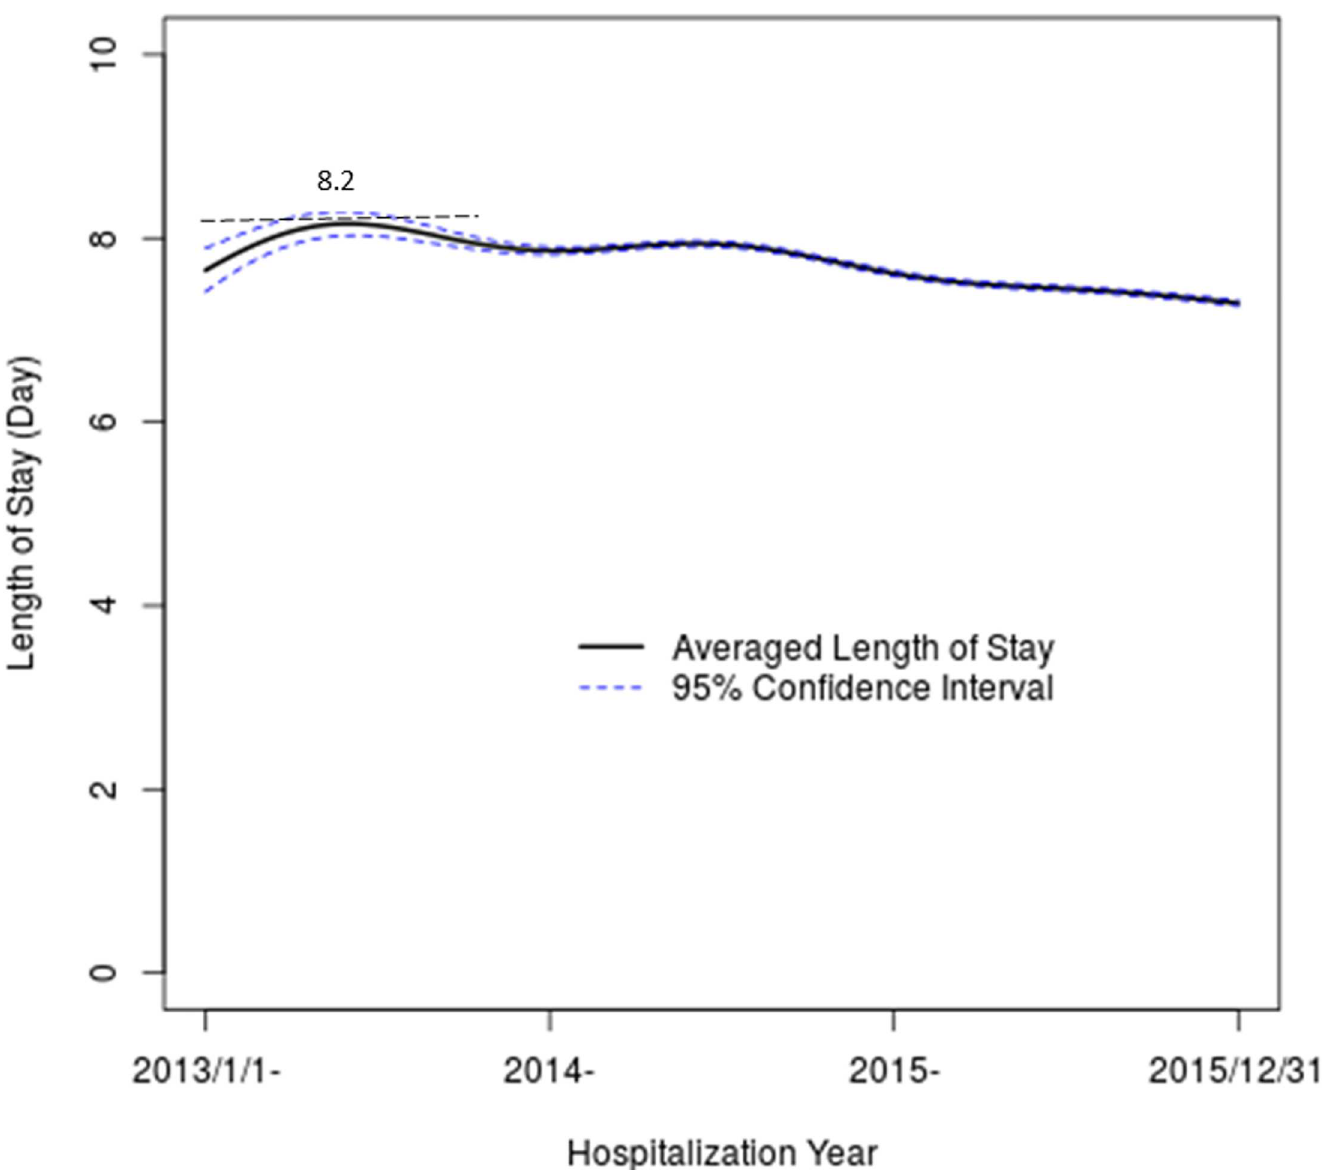
Fig 4. Temporal trends of Length of Stay (LOS) estimated for all hospitalizations of CVD patients, with their 95% confidence bands.